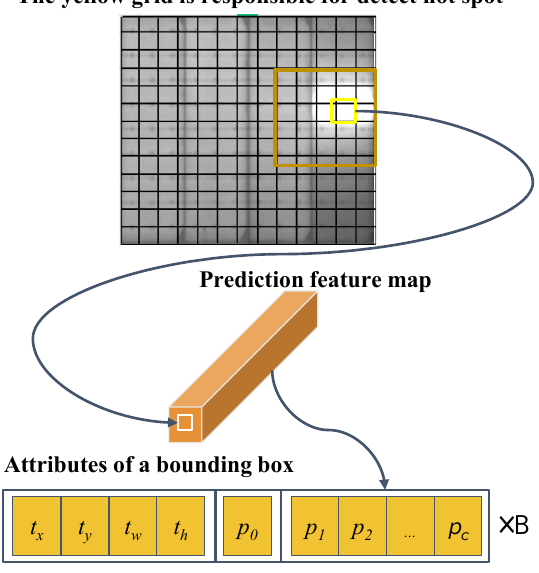
Figure 2. Basic detection idea.